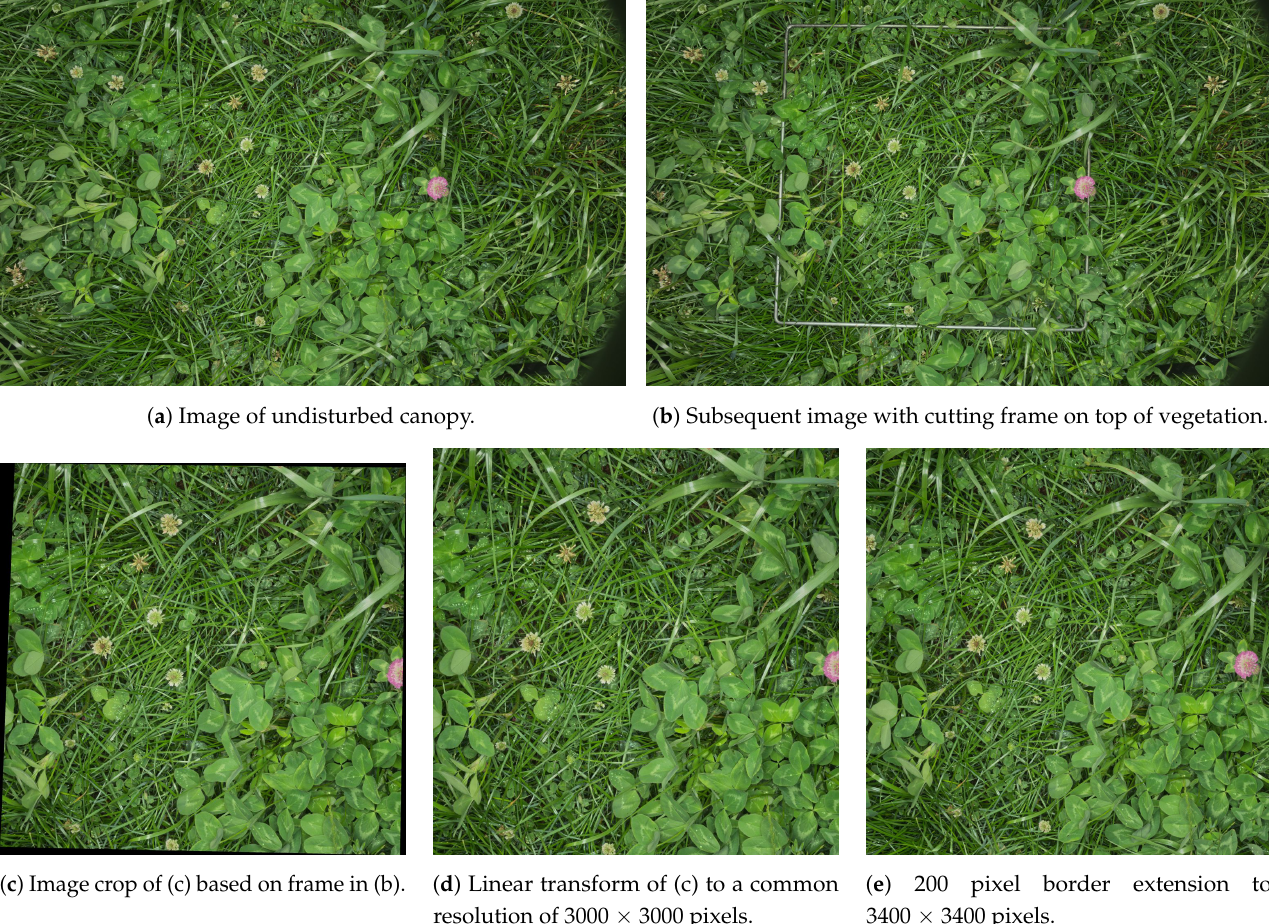
Figure 2. Steps of image preprocessing from captured images to convolutional neural network (CNN)-inference ready